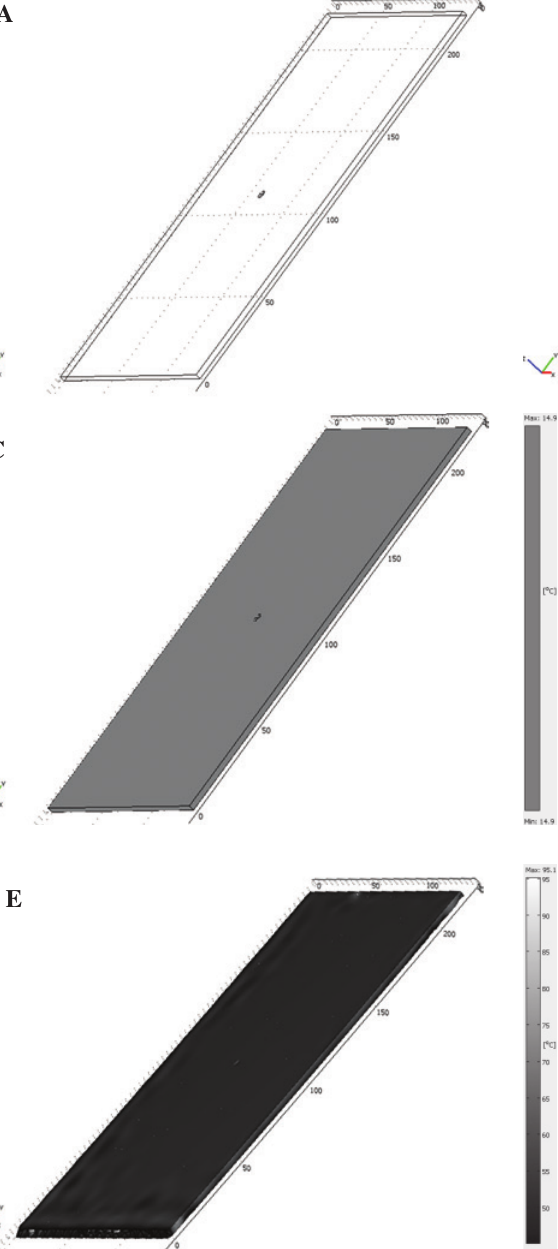
SWIR, and IRT results as explained in the following, have been utilized in order to build a COMSOL ® model (Figure